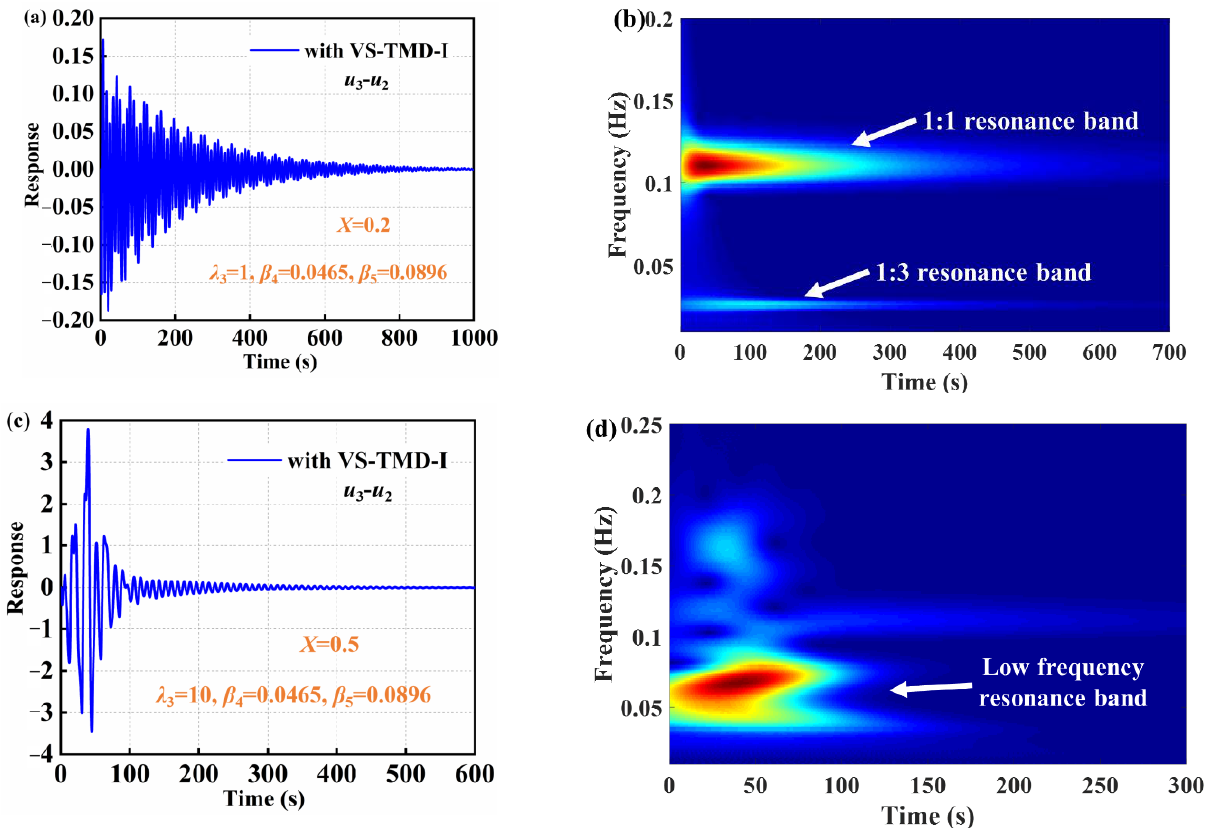
Figure 13. Responses of the relative displacement u 3 - u 2 and the corresponding wavelet transform spectra with various initial impulses: ( a , b ) X = 0.2; ( c , d ) X = 0.5.